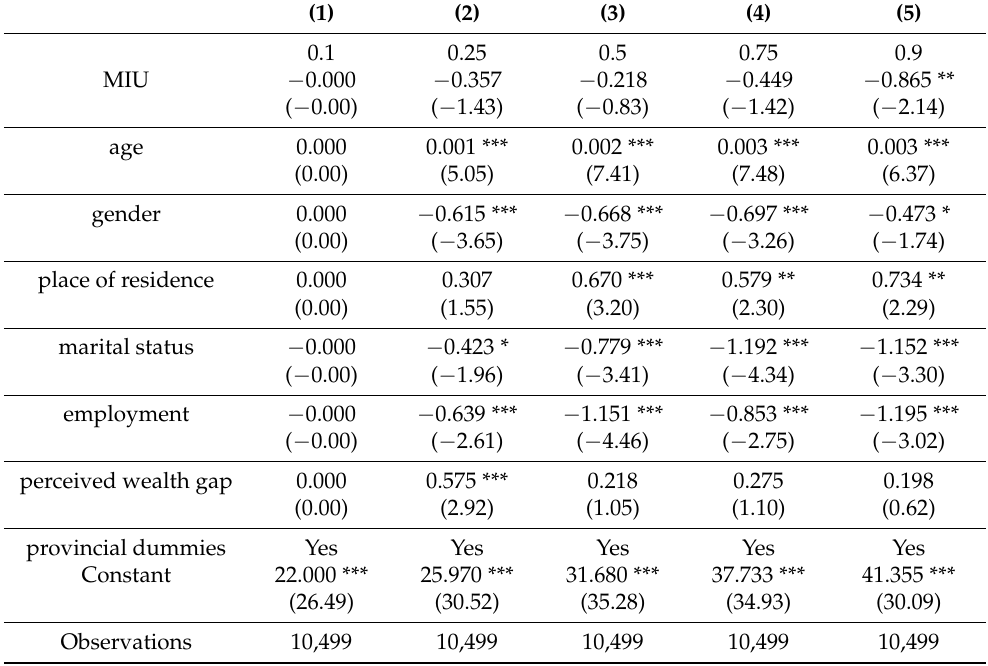
Figure 2. Quantile regression coefficient plot using mobile internet. Table 5. Quantile regression 1.